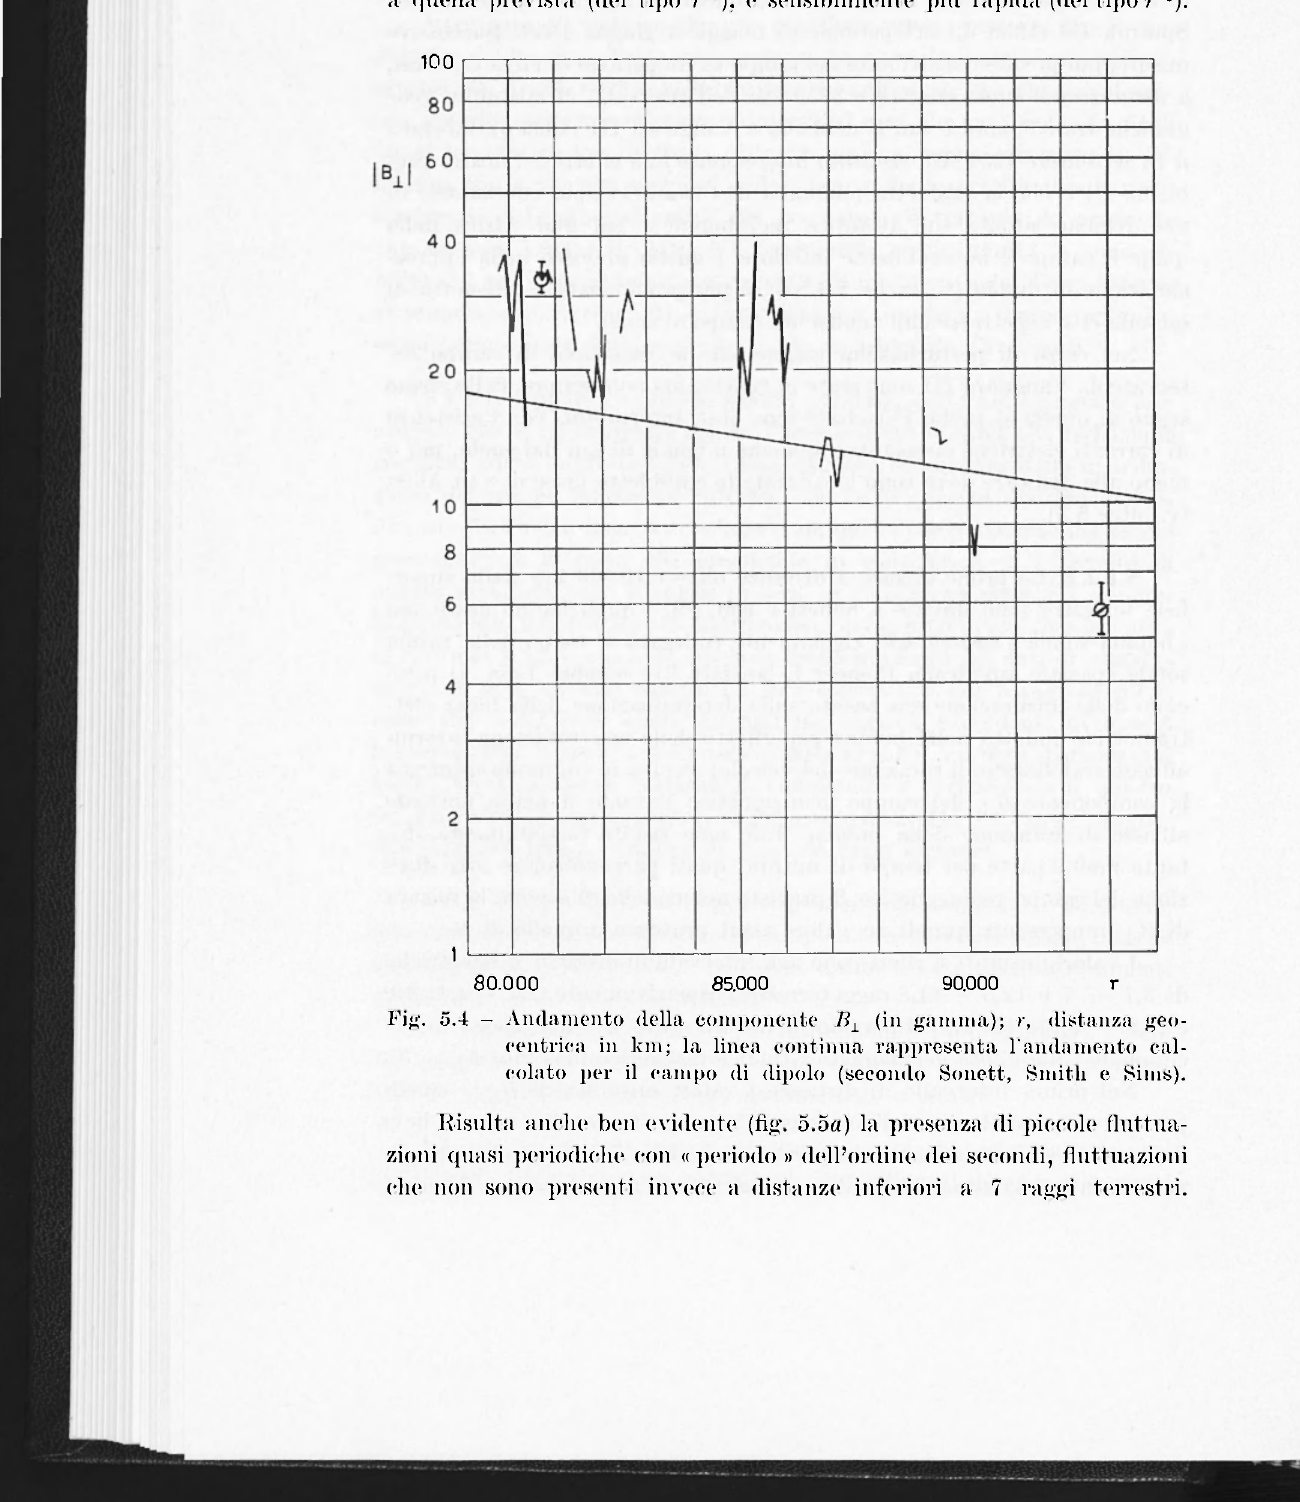
Fig. 5.4 Andamento della componente B L (in gamma); r, distanza geo- centrica in km; la linea continua rappresenta l'andamento cal- colato per il campo di dipolo (secondo Sonett, Smith e